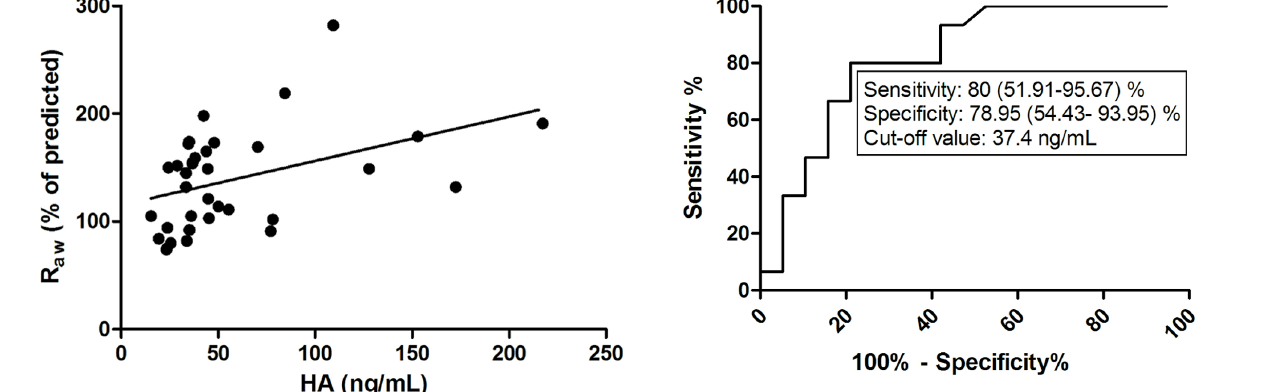
Figure 3. Correlation between HA levels and airway resistance in the asthmatic non-pregnant group. HA – hyaluronic acid; Raw – Airway Resistance; p=0.004; r=0.467.